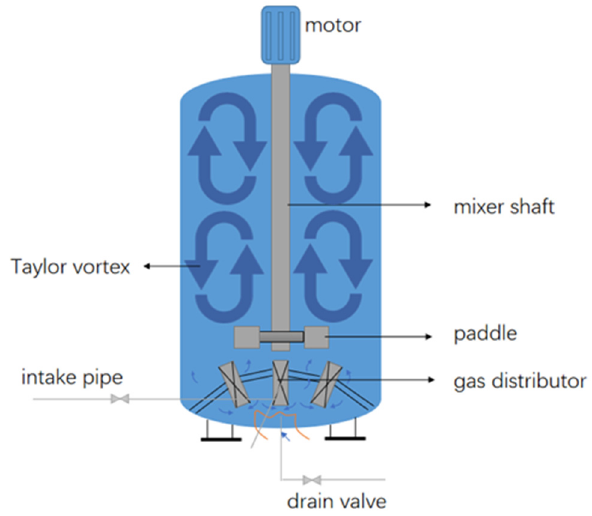
Figure 2. Schematic diagram of stirred tank Taylor reactor.